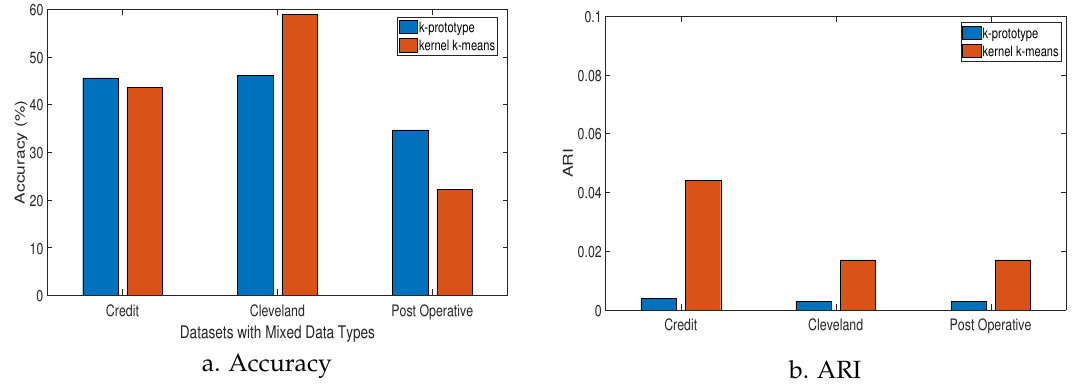
Figure 4. Performance of k-means variants addressing mixed data